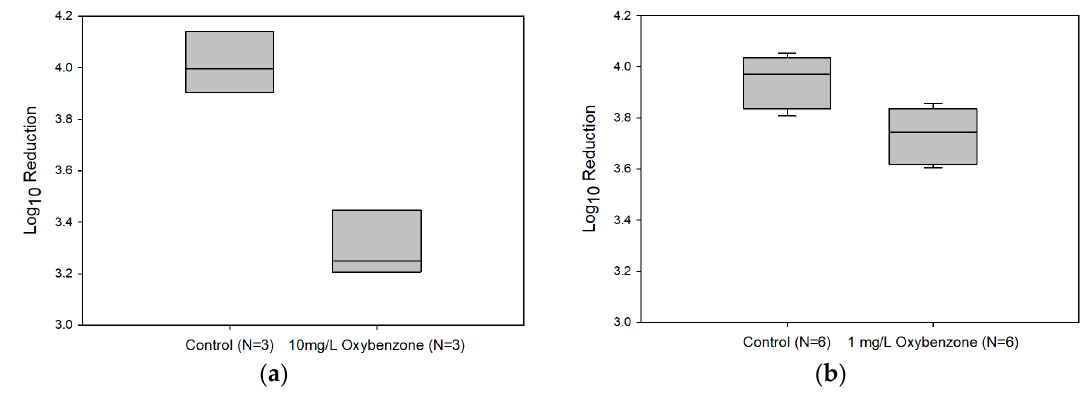
Figure 2. Effects of oxybenzone when irradiating suspended S. aureus at 11.8 mJ·cm − 2 : ( a ) 10 mg·L − 1 oxybenzone; ( b ) 1 mg·L − 1 oxybenzone.